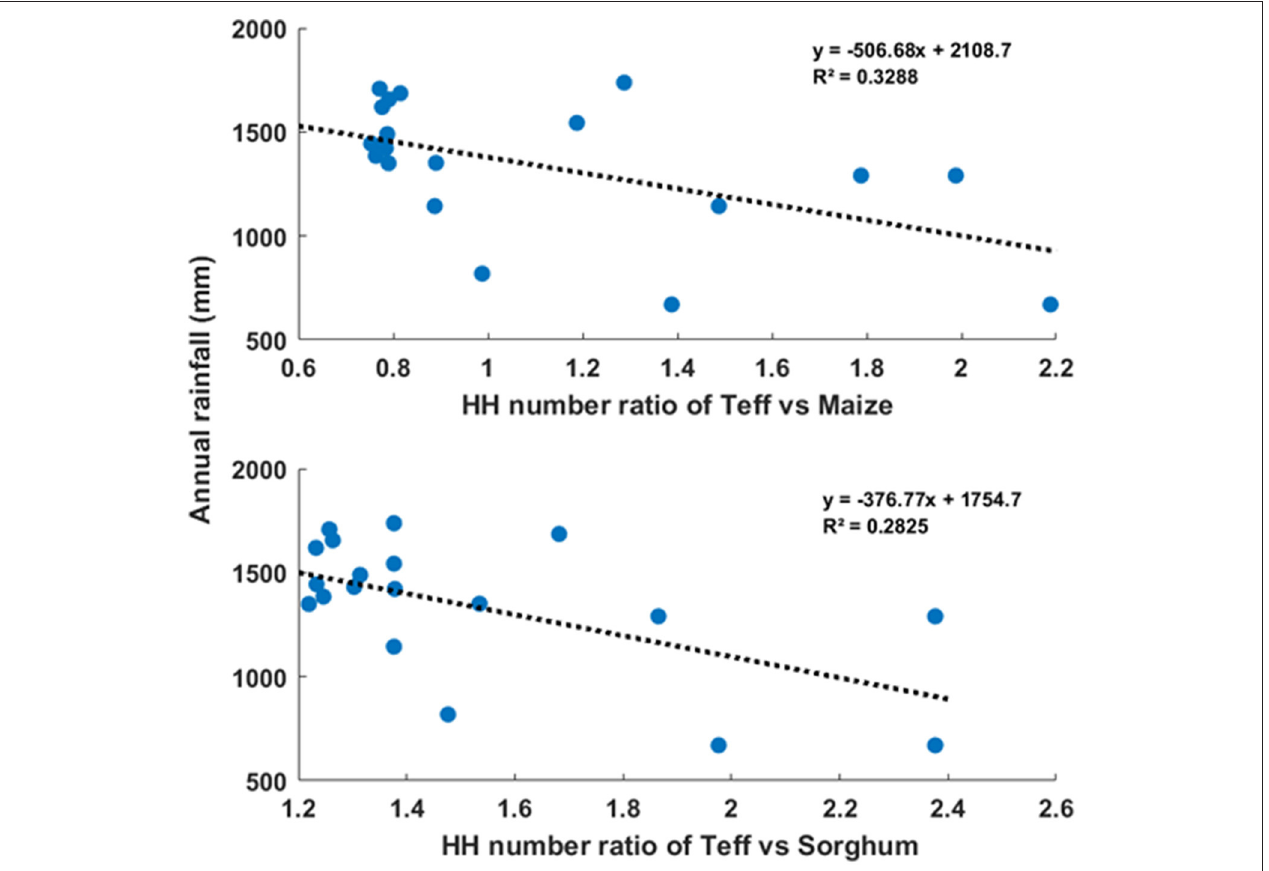
FIGURE 9 | Scatter plots of household (HH) ratios of teff and maize, and teff and sorghum growers, vs. rainfall. Fewer households grow Teff relative to the other two crops when rainfall